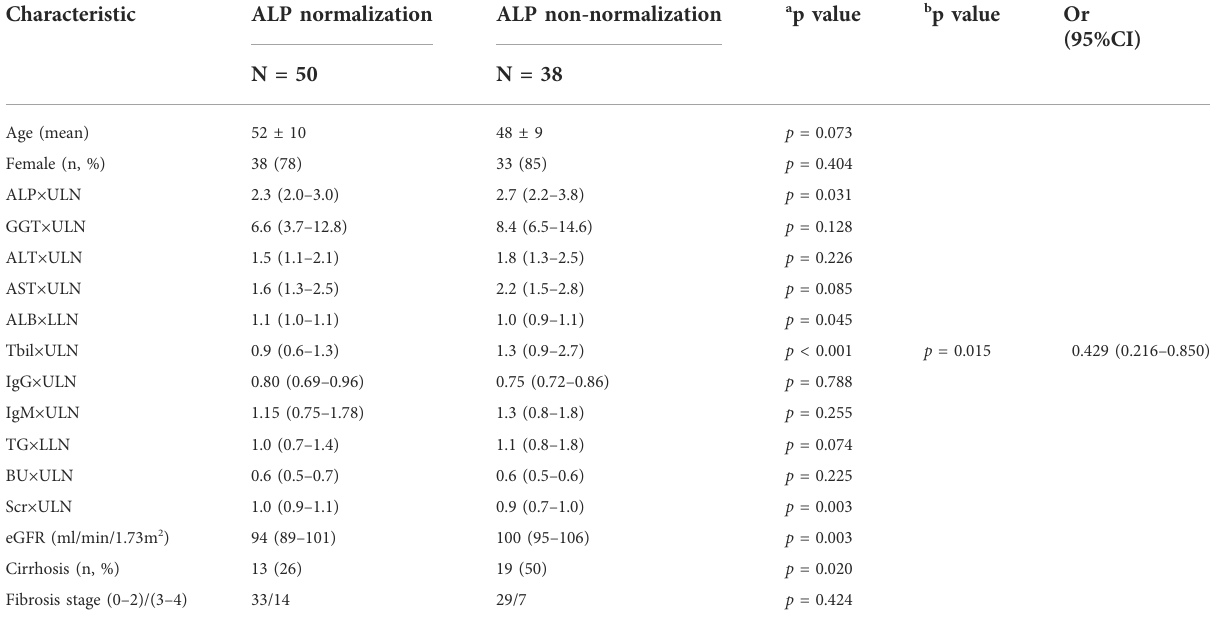
TABLE 4 Baseline characteristics of patients with UDCA-refractory primary biliary cholangitis treated with “ UDCA + FF ” between “ ALP normalization group ” and “ ALP non-normalization group ” . Characteristic ALP